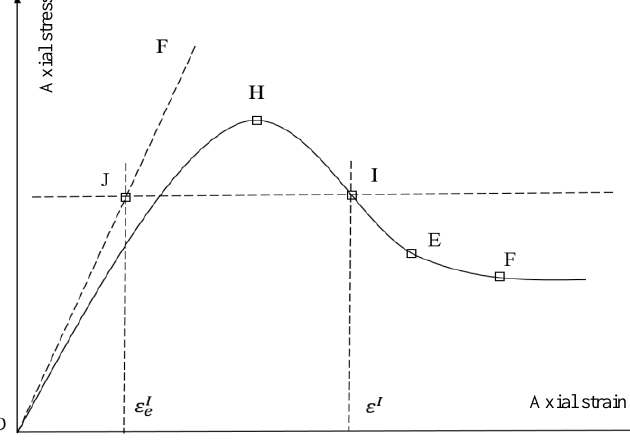
Figure 6. Schematic diagram of damage variable calculation.